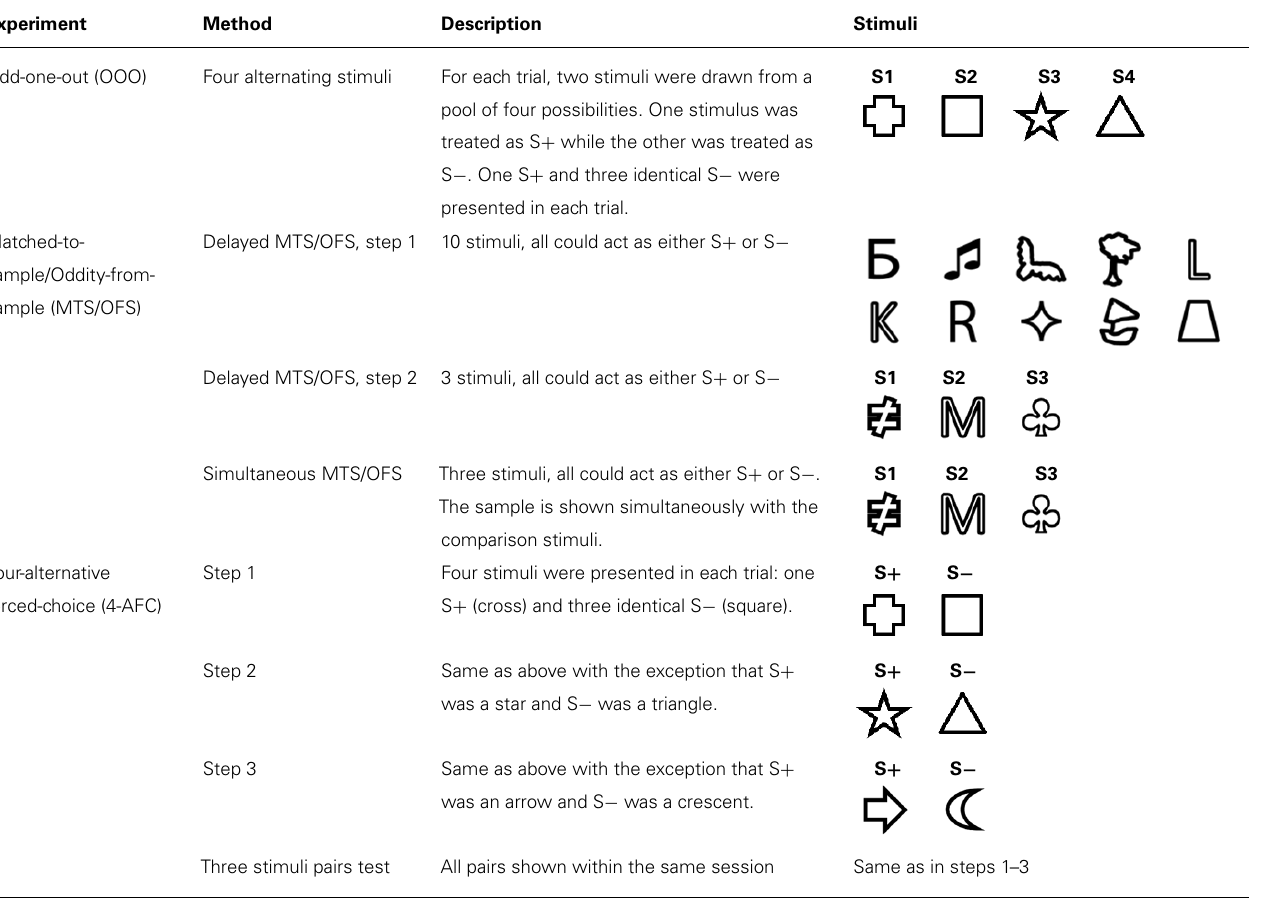
Table 1 | Summary of three experiments describing the stimuli used and brief experimental description.